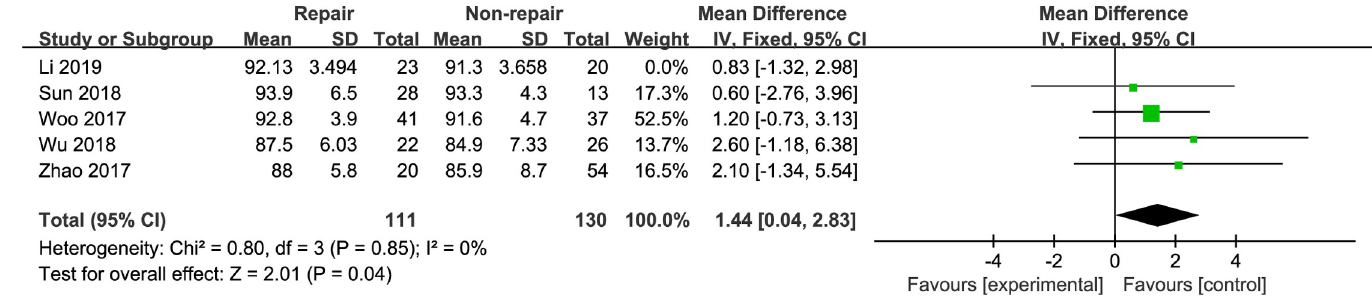
Fig 7. The forest plot of AOFAS ankle-hindfoot score after sensitivity analysis.